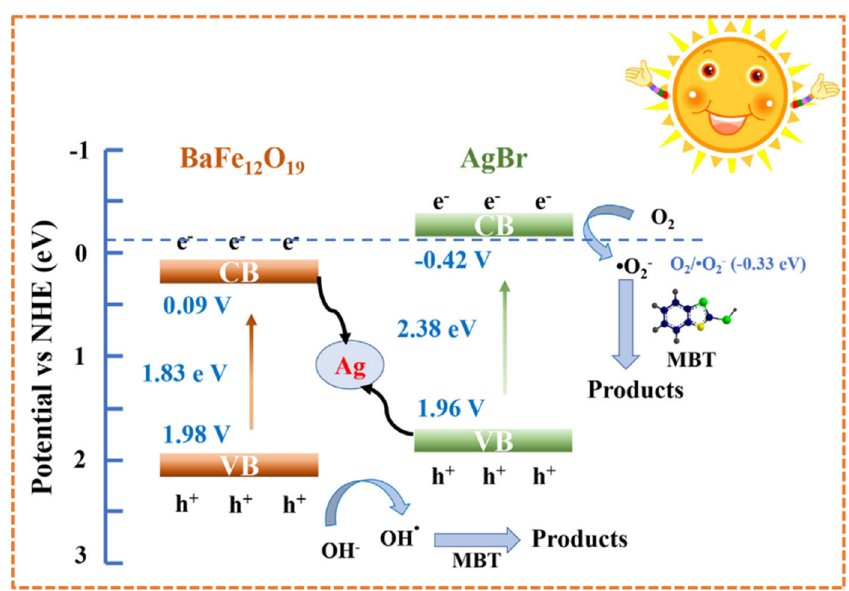
Figure 9. The schematic illustration of the proposed mechanism for degradation of 2 ‐ mercaptoben ‐ zothiazole over the ternary BaFe 12 O 19 /Ag/AgBr nanocomposite. Reprinted with permission from [136]. Copyright (2020)